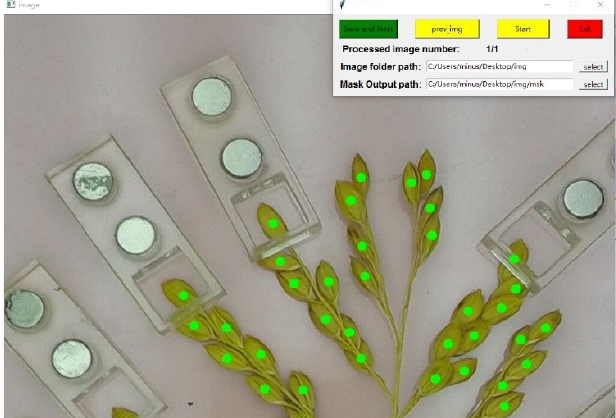
4 of 12 Figure 3. The human–computer interaction interface of the dot mark.